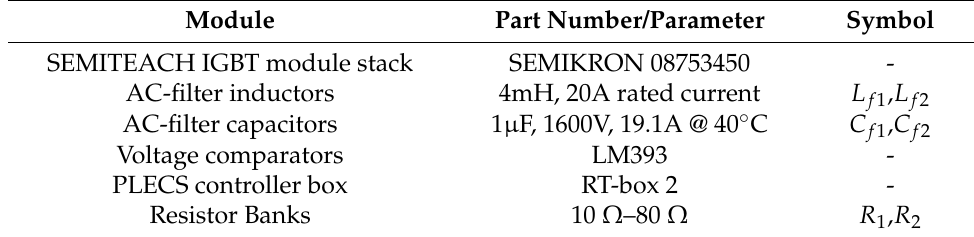
Figure 9. Experimental prototype of the multi-converter system. Table 5. Experimental system specifications.